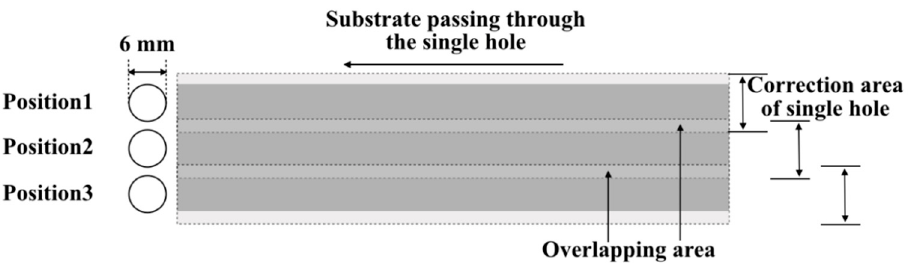
Figure 12. Schematic diagram of the correction process.